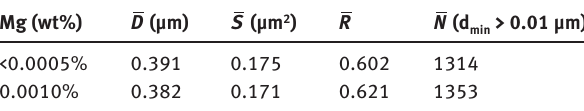
Table 5: Statistical results of carbides in H13 steel